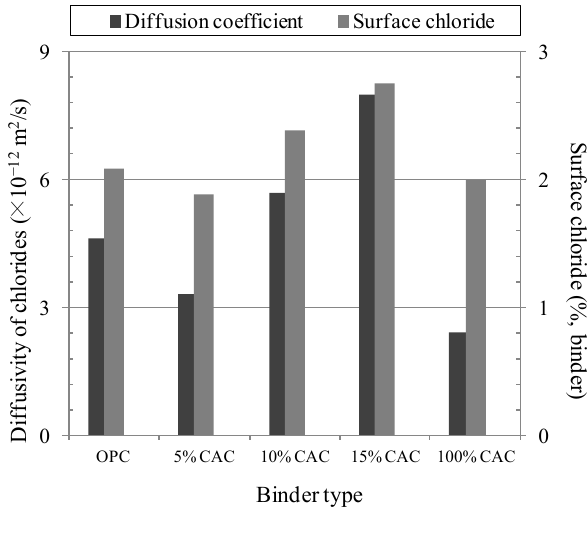
Figure 3. Rate of chloride transport in terms of ionic diffusion with surface chloride.